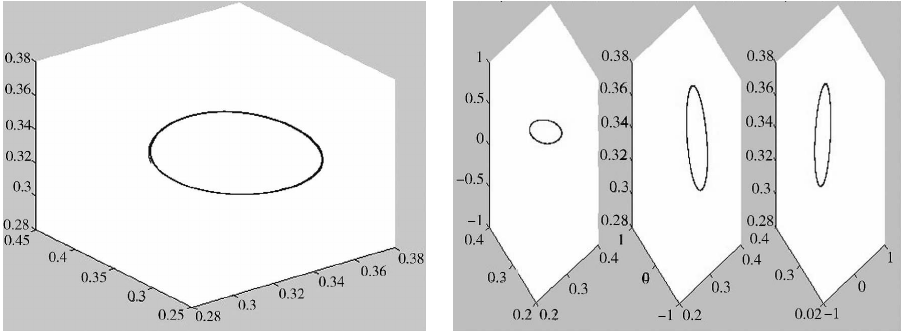
Fig. 7 Orbital diagram of parameter = 0 and evolution time of 6000-unit time points